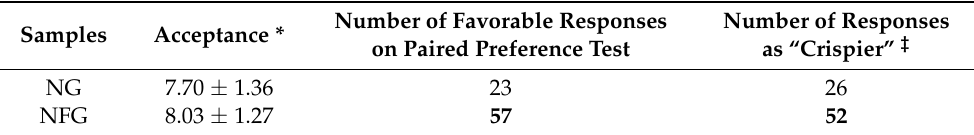
Table 2. Results from sensory evaluation of nachos covered with guacamole (NG) or with film (film #3, produced by continuous casting) and guacamole